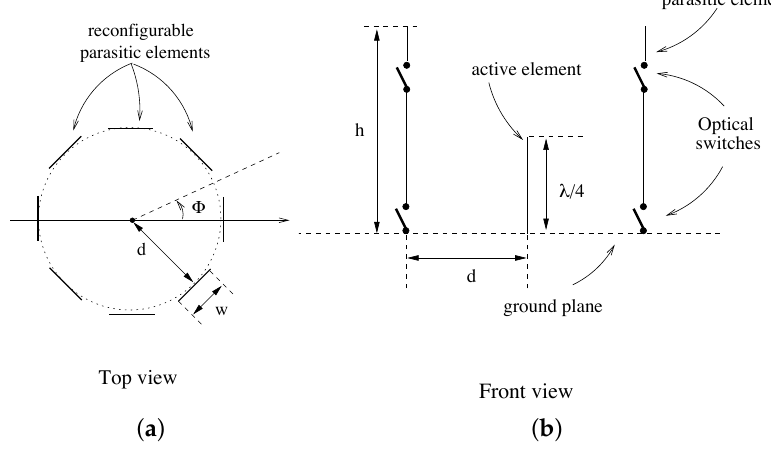
Figure 3. Beam pattern for different parasitic structure configurations. ( a ) top view; ( b ) side